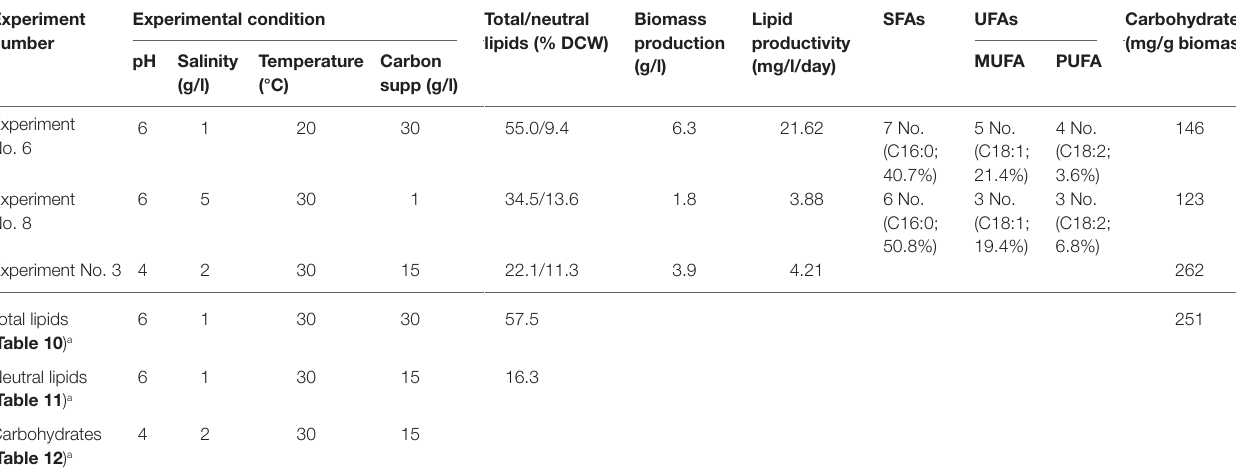
TaBle 14 | consolidate optimum conditions toward biomass and lipid production obtained from the